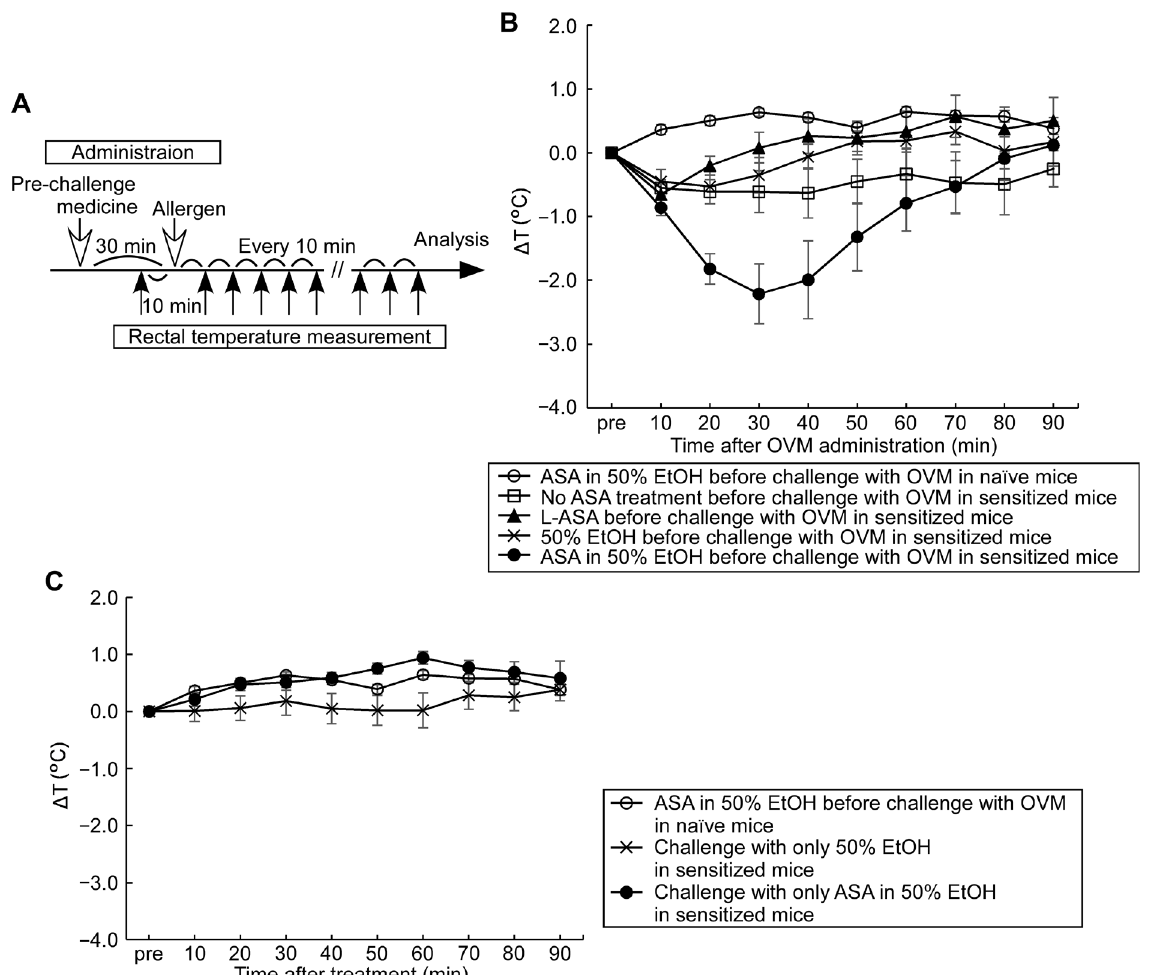
Figure 2. Effects of oral pre-medication with ASA and its derivative, L-ASA on oral-OVM-challenge- induced fall in rectal temperature. ( A ) Oral challenge protocol ( n = 10/group); ( B ) ΔT after 20 mg OVM challenge in sensitized and naïve mice with and without 30 min pre-medication of ASA at 50 mg/kg, an equivalent dose of L-ASA at 91 mg/kg and 50% EtOH; ( C ) ΔT without oral OVM challenge in sensitized mice pre-medicated with ASA at 50 mg/kg or 50% EtOH and ΔT in naïve mice treated with 50 mg/kg ASA and OVM challenge as a comparison group. Data are mean ± SEMs.